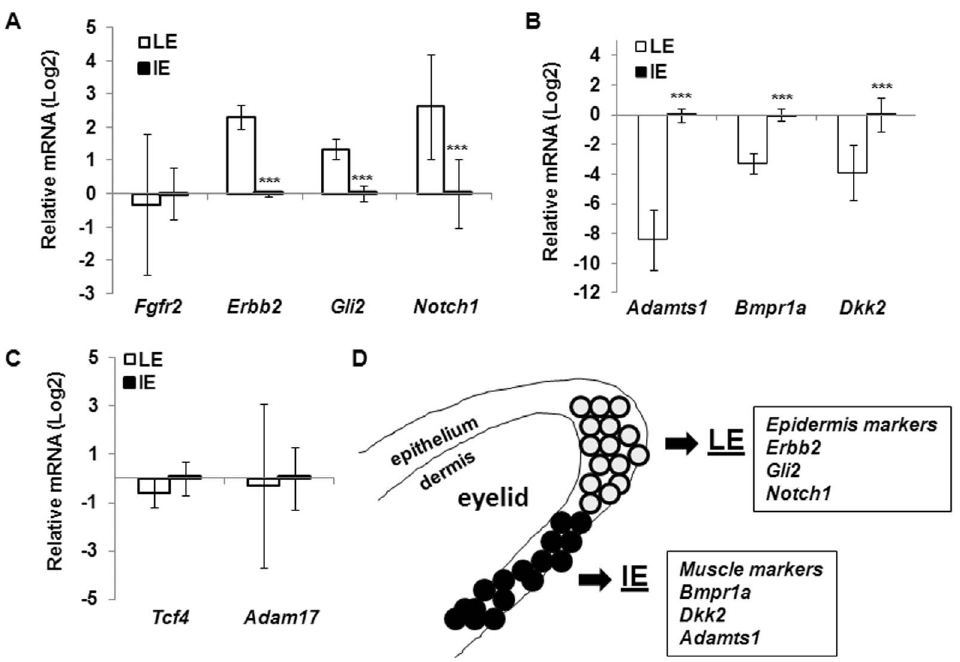
Figure 2. Differential gene expression in LE and IE cells. Total RNA isolated from LE and IE cells of fetuses at E15.5 was used for qRT-PCR for the expression of (A) Fgfr2 , Errb2 , Gli2 and Notch1 , (B) Adamts1 , Bmpr1a and Dkk2 and (C) Tcf4 and Adam17 . Relative expression was calculated based on that of Gapdh in each sample, and compared to the expression in IE cells, set as 1. The results are shown as mean 6 SD from at least 3 samples and triplicate PCR of each sample. Statistic analyses were done by Student t-test, ***p , 0.001 is considered significant. (D) Figure depicting the LE and IE cells in the developing eyelid and expresison of signaling factors.